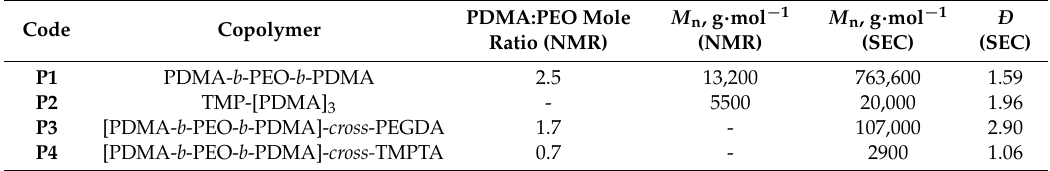
Table 1. Macromolecular characteristics of the developed linear and branched